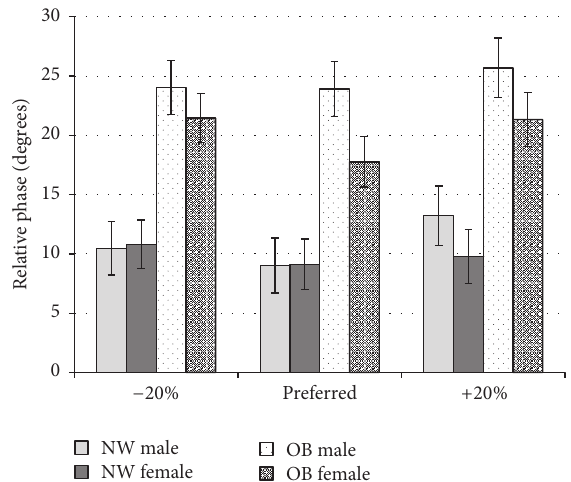
Figure 3: Mean standard deviation values shown for normal weight (NW), and obese (OB) participants by gender for each frequency ( − 20%, preferred frequency, and +20%).